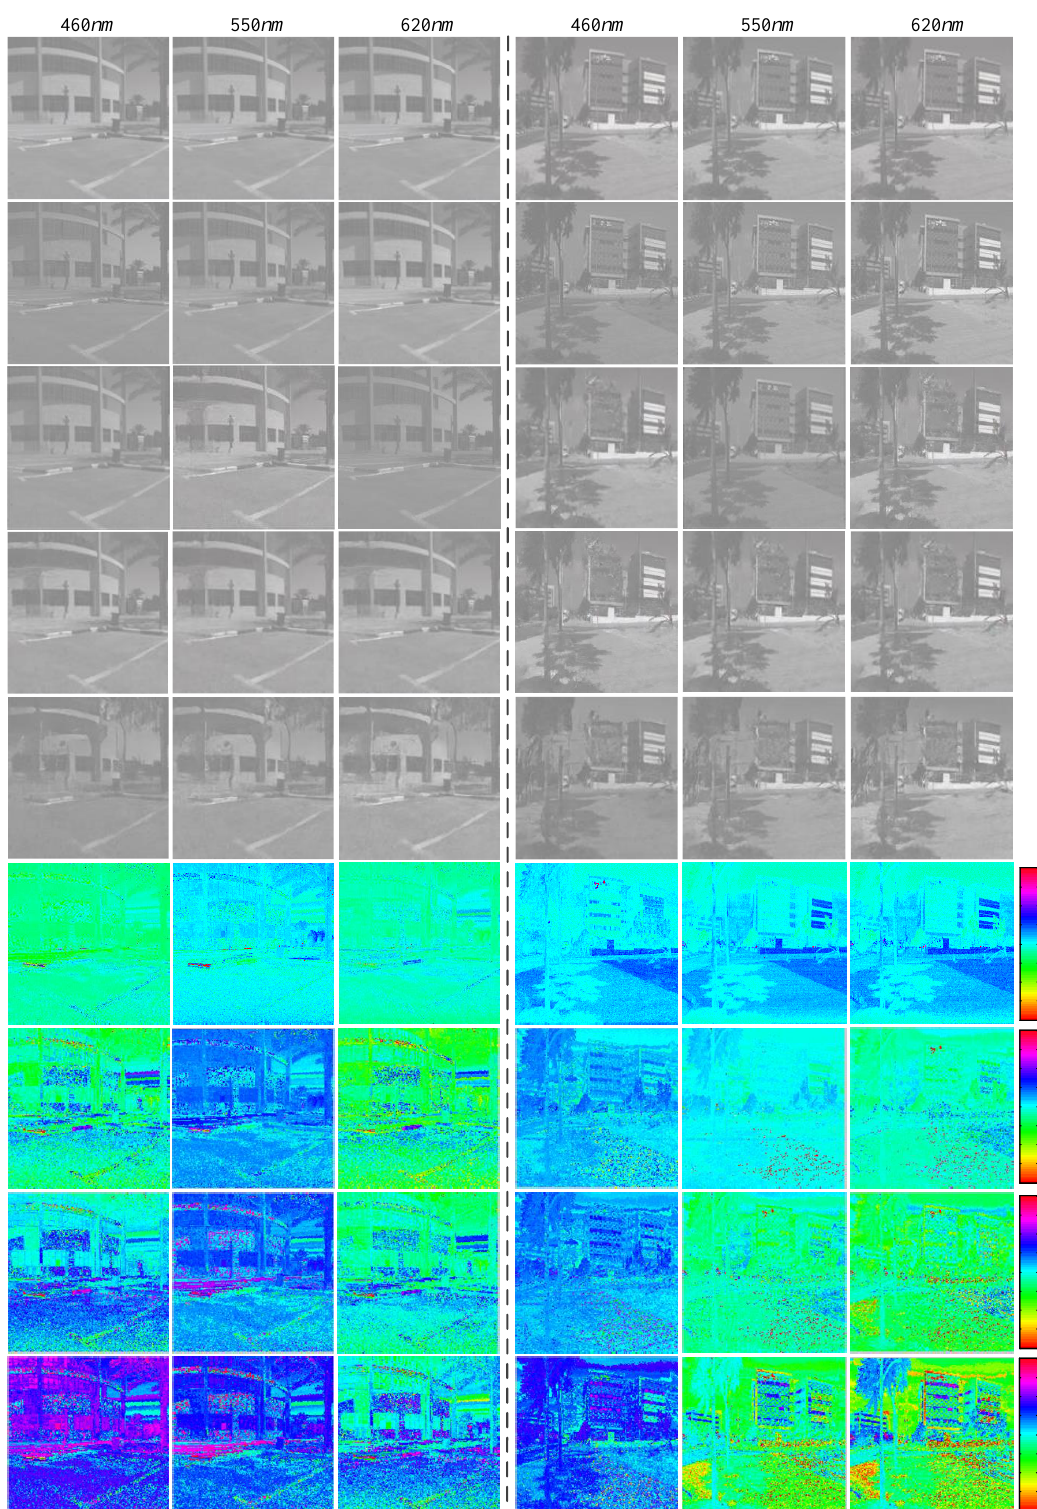
Figure 5. Reconstruction images from the ICVL dataset [3]. From top to bottom, ground-truth, SAPWNet-GAN, SCAUNet-GAN [30], sparse coding [3], and error map of the